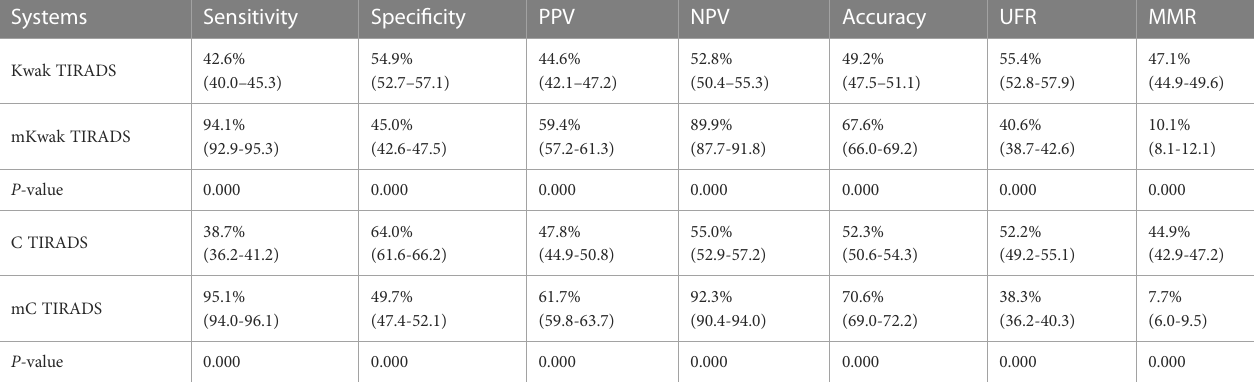
TABLE 5 Comparison of the diagnostic performances between original TIRADS and modi fi ed TIRADS.